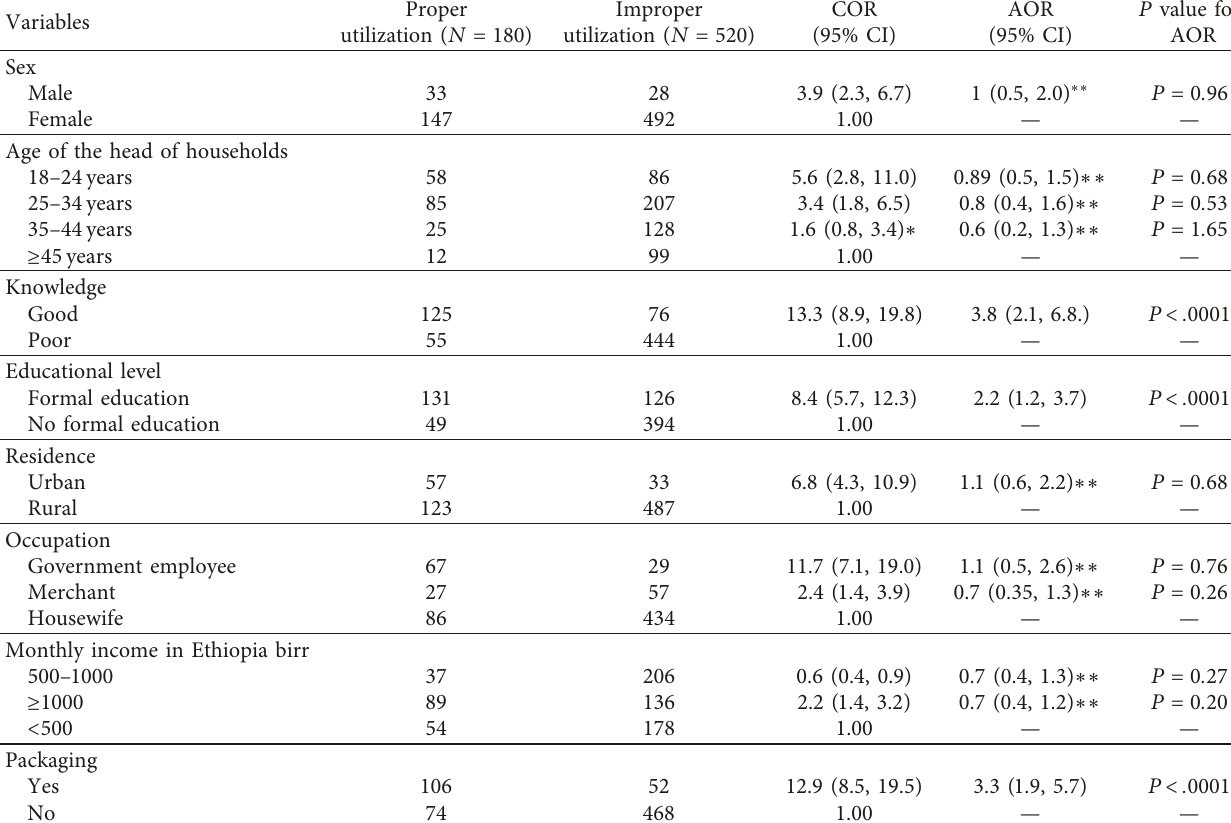
Table 5: Factors associated with utilization of adequately iodized salt at the household level in Mecha district, Western Amhara, Ethiopia, 2018 ( N � 700).